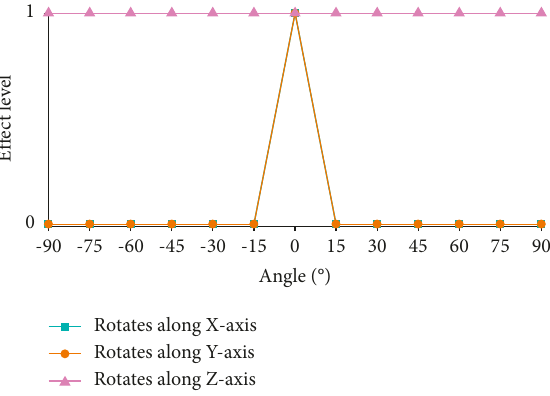
Rotates along Y-axis Rotates along Z-axis Figure 20: The most sensitive pose of the detector.